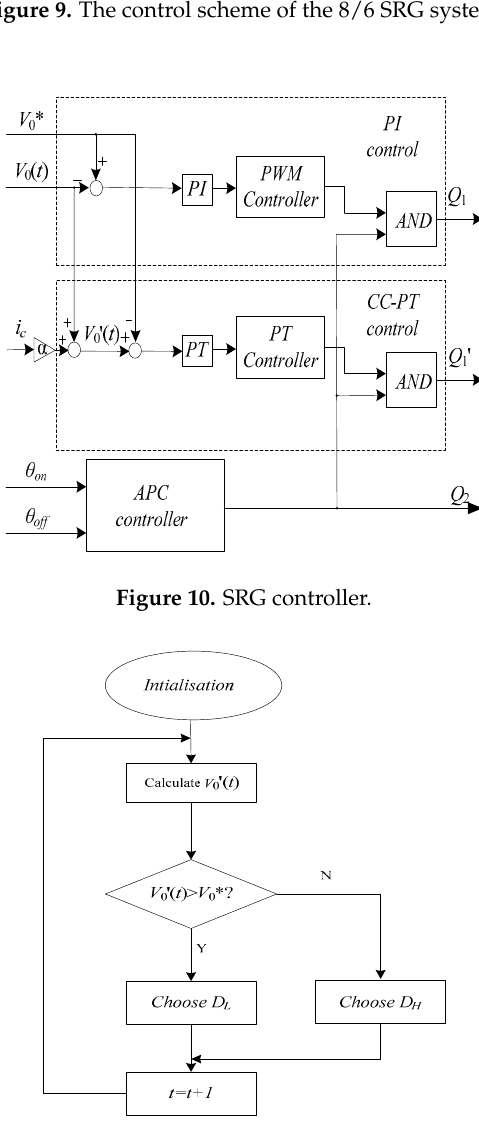
Figure 11. Flowchart of the STM 32 controller.